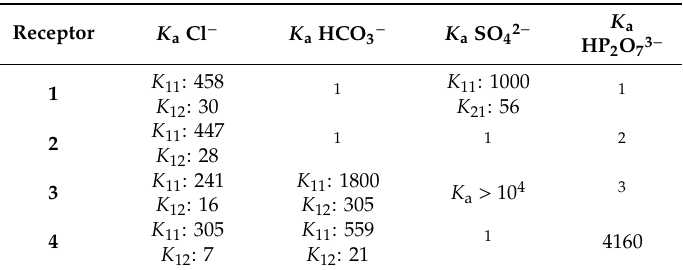
(Table 1), in contrast to the 1:1 binding seen in the tris tert -butyl thiourea bicarbonate titration [19]. Table 1. The complexation binding constants K a (M − 1 ) of receptors 1 – 4 to di ff erent anions determined in 1 H-NMR binding studies performed in DMSO-d 6 / 0.5% water. Anions were added as tetrabutylammonium salts (except in the case of bicarbonate which was added as the tetraethylammonium